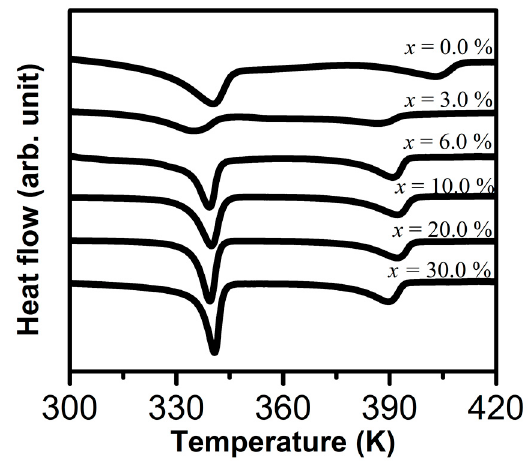
Figure 2. DSC thermograms for (PEO) 10 CF 3 COONa + x wt.% Al 2 O 3 composite ( x = 0.0, 3.0, 6.0, 10.0, 20.0, and 30.0). Table 1. Endothermic anomaly enthalpies for di ff erent composites (PEO) 10 CF 3 COONa + x wt.% Al 2 O 3